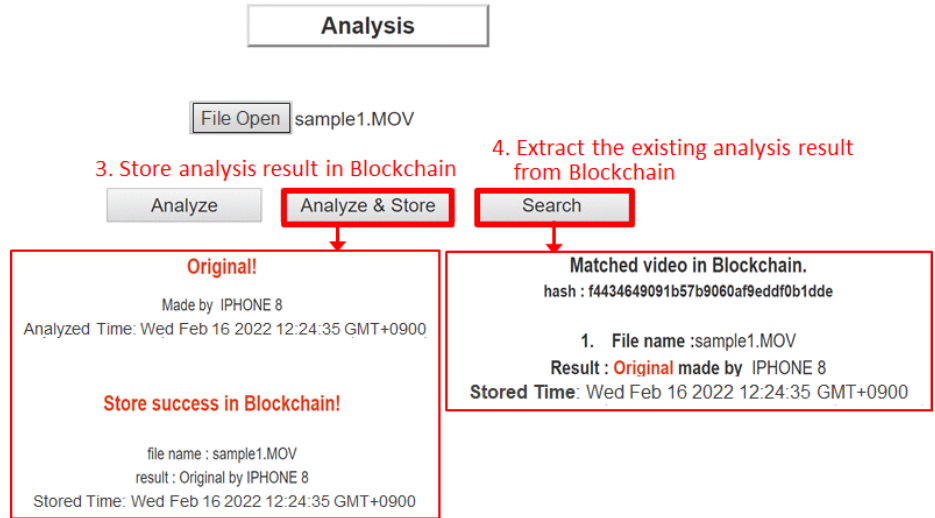
Figure 8. Storing and searching the integrity analysis result on the blockchain